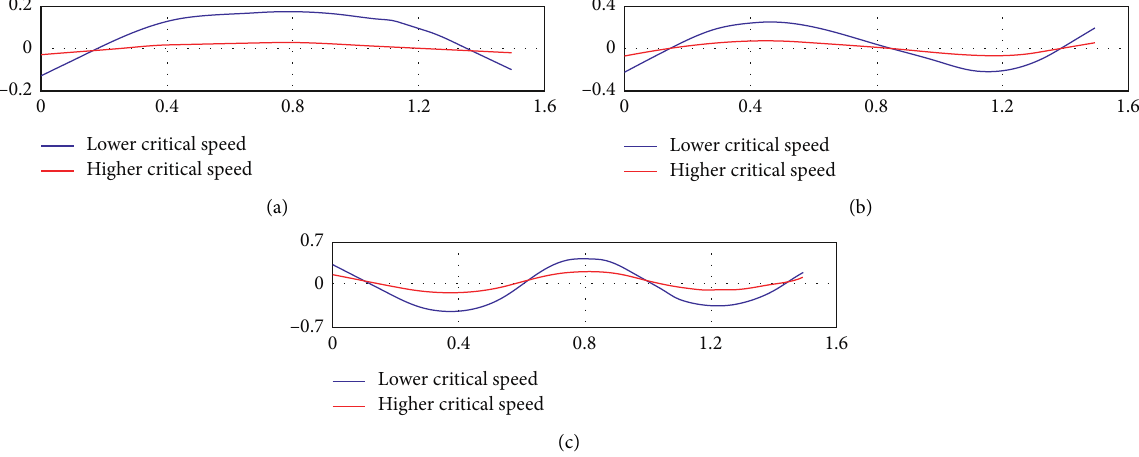
Figure 7: Mode shape of rod fastened rotor. (a) 1st mode shape, (b) 2nd mode shape, and (c) 3rd mode shape.